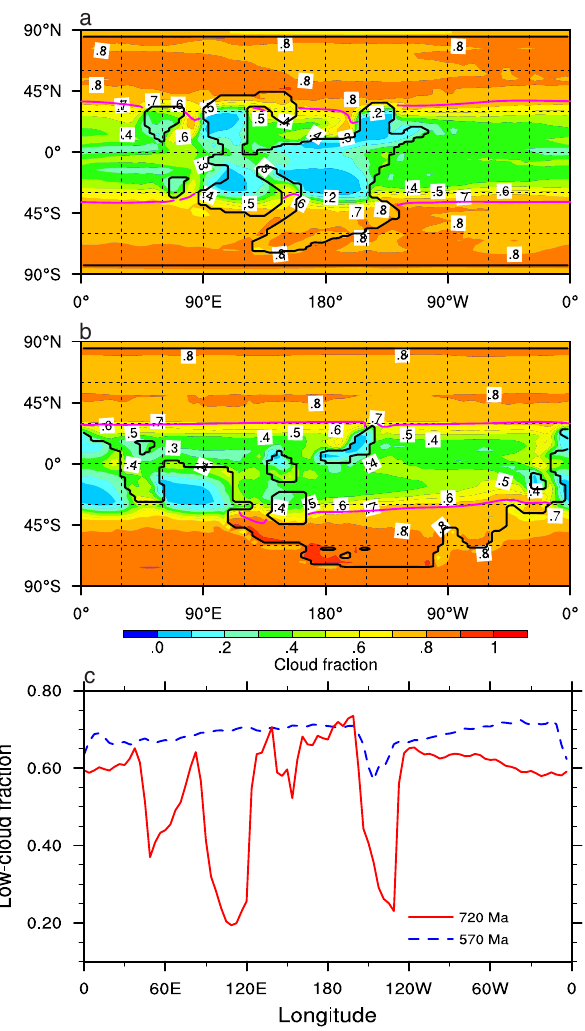
Fig. 12. The 100yr low-level cloud fraction over the globe for (a) 720Ma and (b) 570Ma continental configurations, and (c) along the 30 ◦ N latitude. The contour lines for grid-box sea-ice fraction of 50% (pink curves, taken as the sea-ice edges) are also superimposed in (a) and (b) . The profound dips of the red curve in (c) are all over land areas. TSI = 0.94TSI 0 , τ = 0 . 12, p CO 2 = 140ppmv for both two